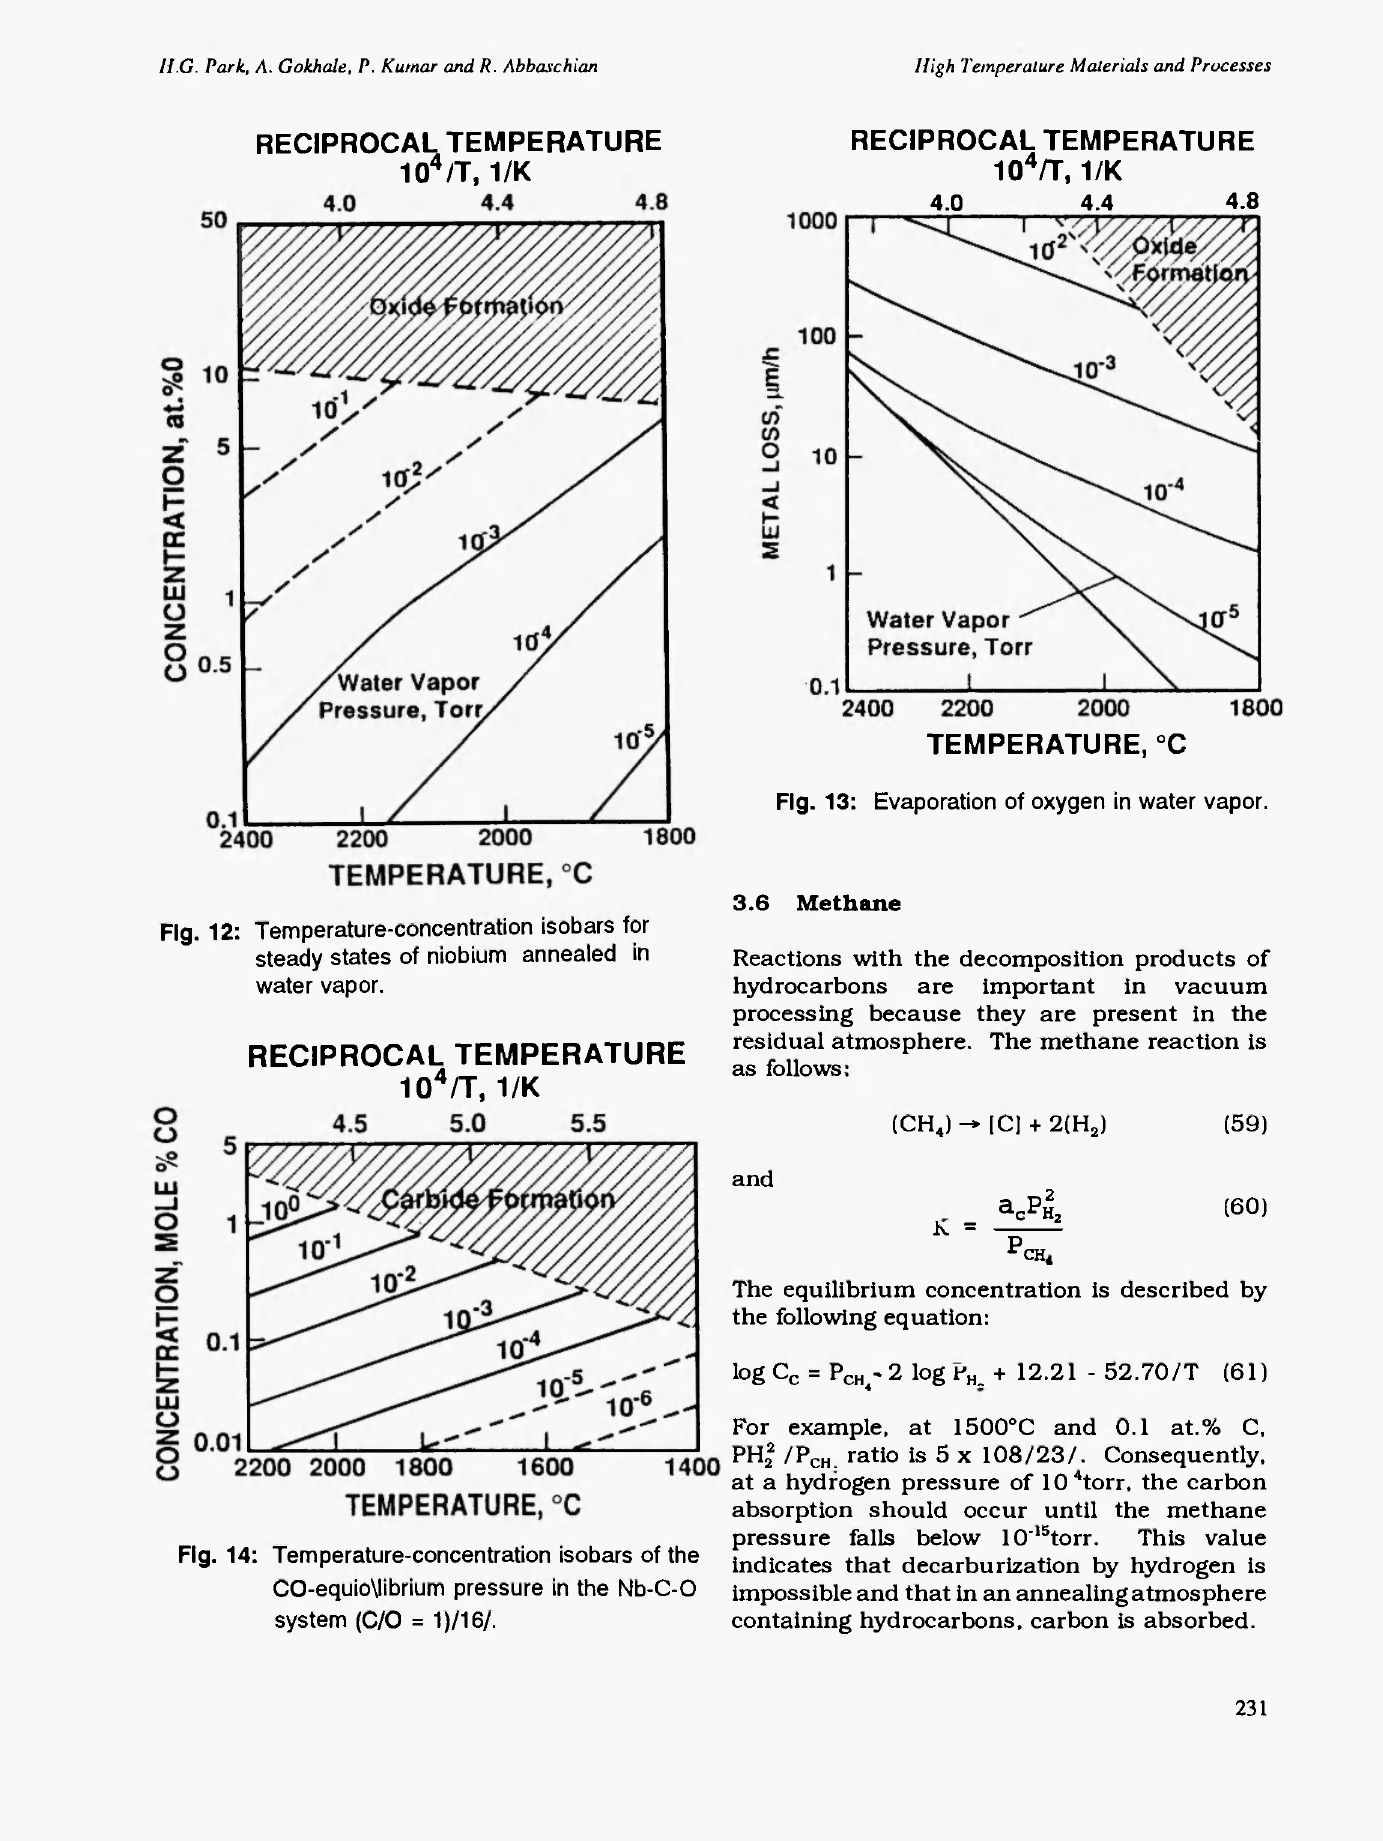
Fig. 13: Evaporation of oxygen in water